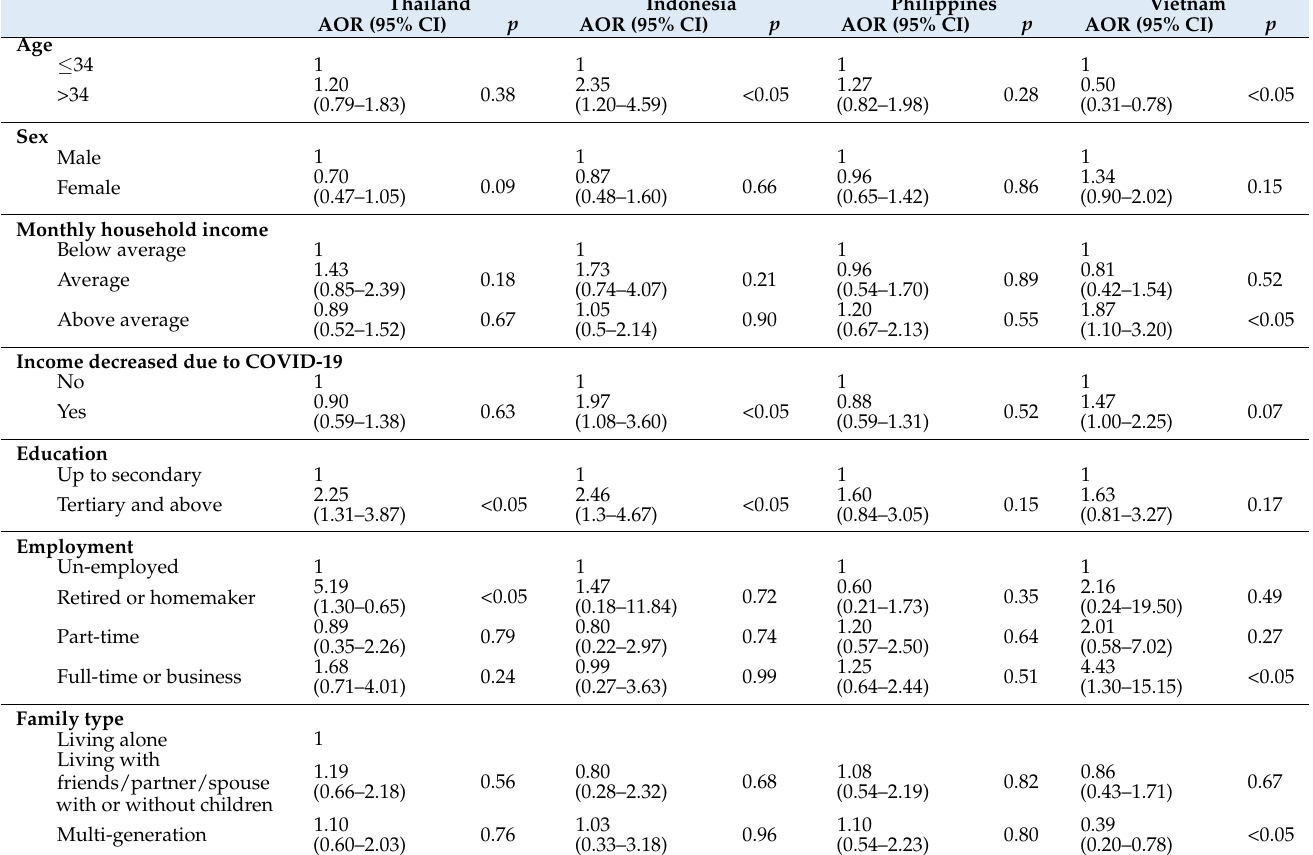
Table 8. Binomial logistic regression of willingness for vaccine with sociodemographic